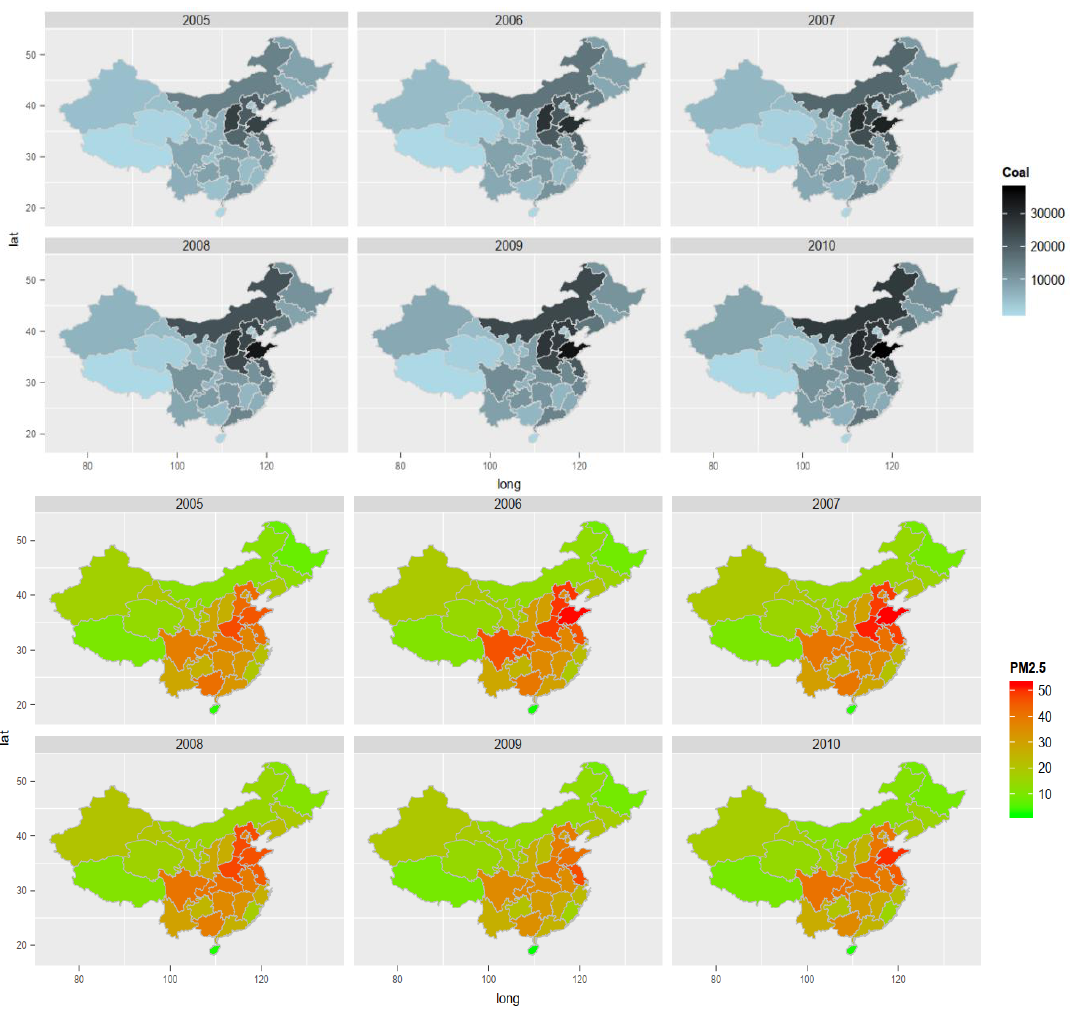
Figure 1. Mapping annual coal consumption and surface distribution of population-weighted exposure to PM 2.5 concentration in China for the years 2005 to 2010.